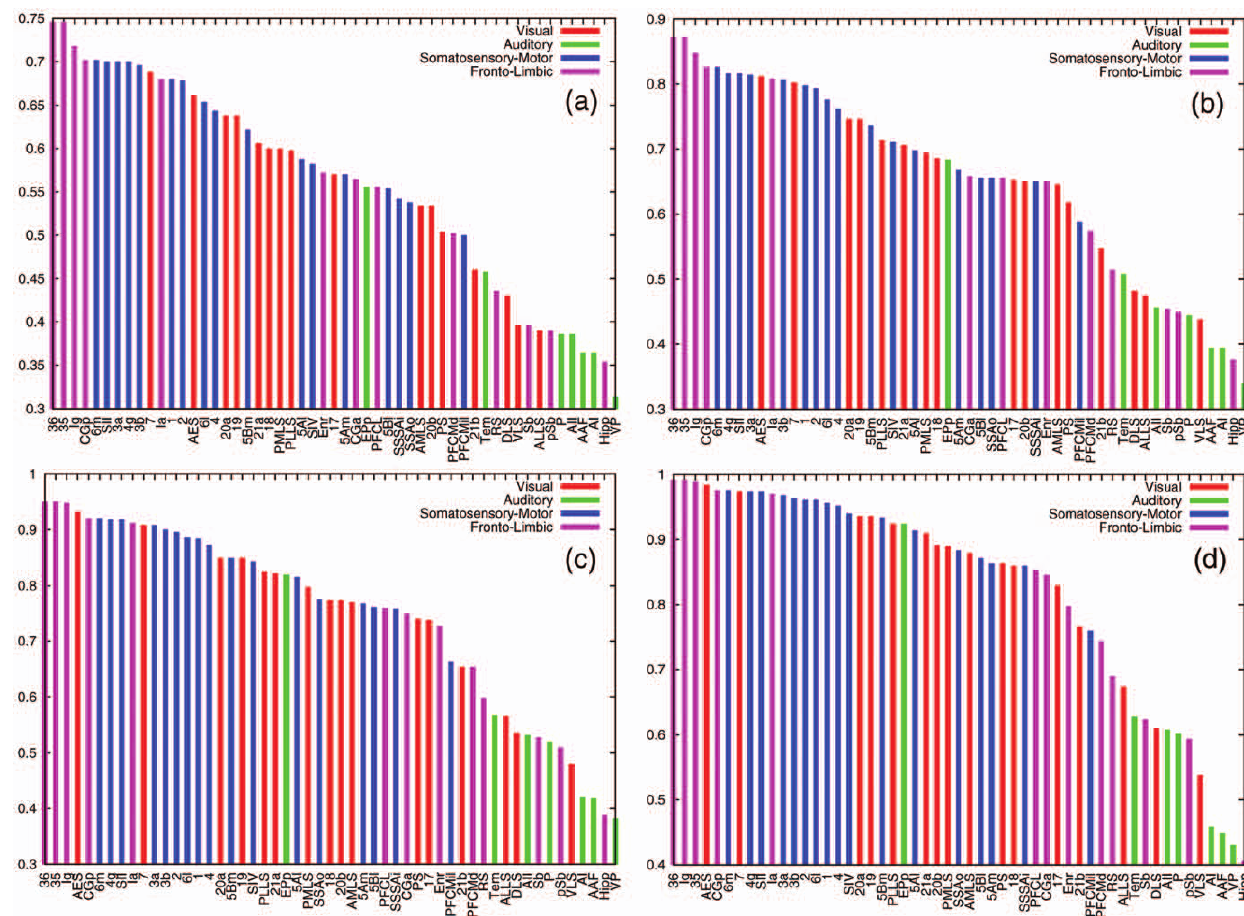
Figure 5. Synchrony Rank of areas: Unveiling anatomical structure of the largest synchronized areas. In these plots we show the rank of areas fromthemosttothelesssynchronizedfor l ~ 0 : 015 (a), 0 : 017 (b), 0 : 019 (c)and 0 : 021 (d).Theheightofthebarsaccountofthemaximumvalueofthethreshold, T i , at which the area is incorporated in the synchronized subgraph. Besides, the colour of each bar accounts for the corresponding module of the cortical area.